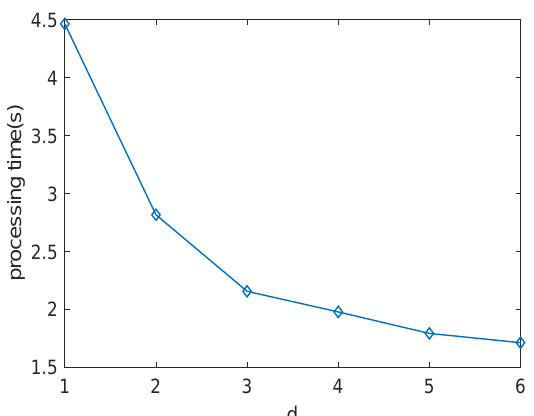
Figure 8. Processing time varied with the (unilateral) included